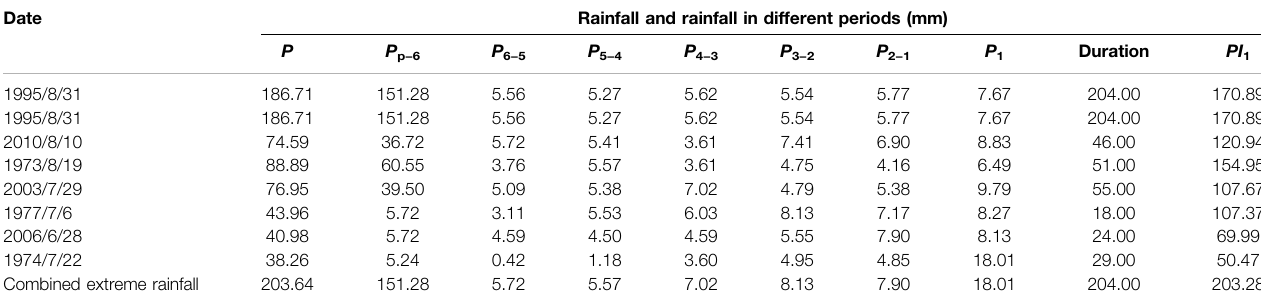
TABLE 4 | Extreme rainfall obtained by the method of historical extreme rainfall combination.